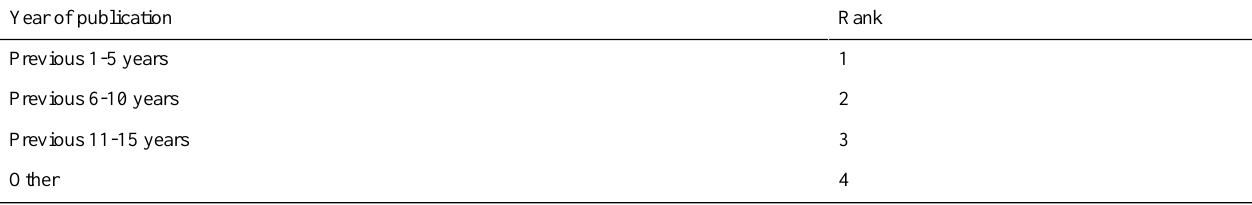
Table 2. Assigned weights for research study year of